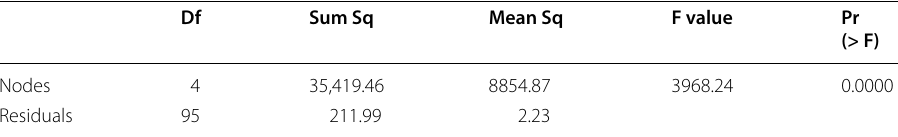
Table 2 Tukey’s HSD test with groupings